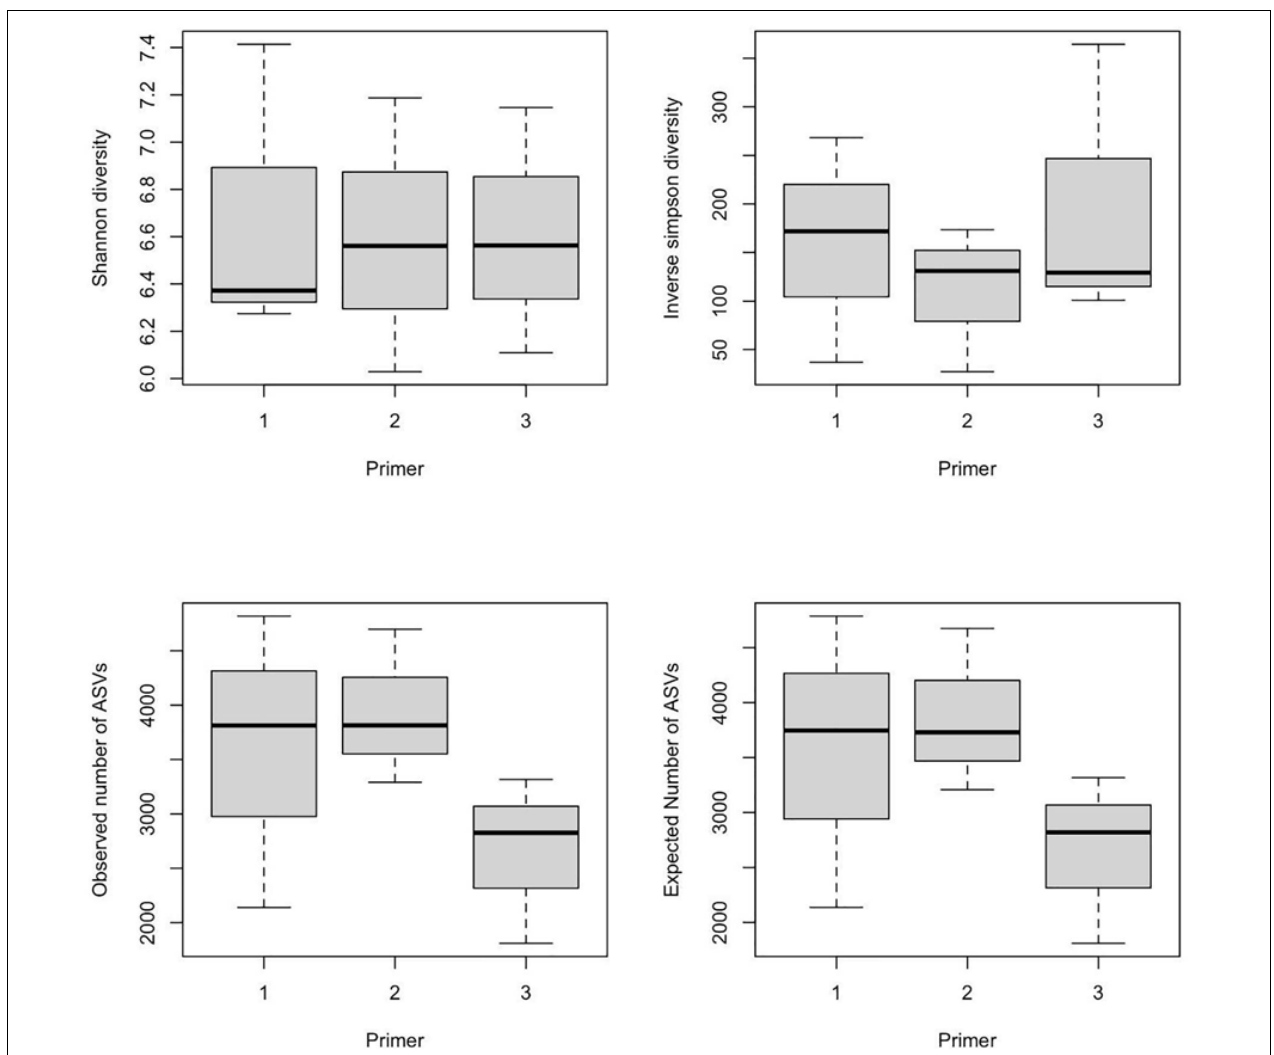
FIGURE 5 | Primer-wise comparison of different prokaryote ASV α -diversity indices (Shanon and inverse Simpson) and richness (observed ASVs and expected ASVs). The data are pooled over three wetlands for each primer. The numerics and abbreviations used are as follows: 1, 341b4_F/806_R; 2, N341b4_F/806_R; 3, Pro341F/Pro805R; ASV, amplicon sequence